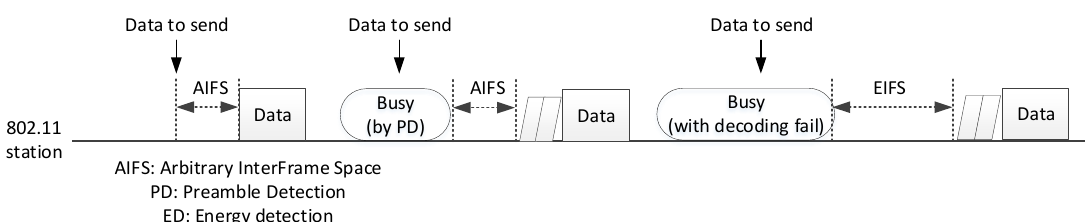
Figure 2. Channel access scheme in IEEE 802.11p.